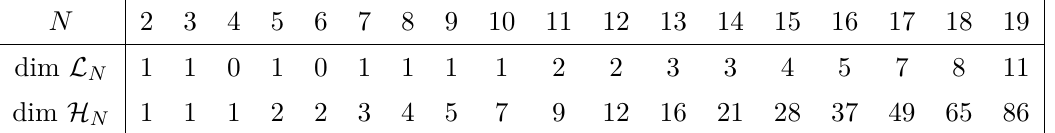
Table 2 . Dimensions of the space H ( L ) of multiple zeta values of weight N (modulo products). N